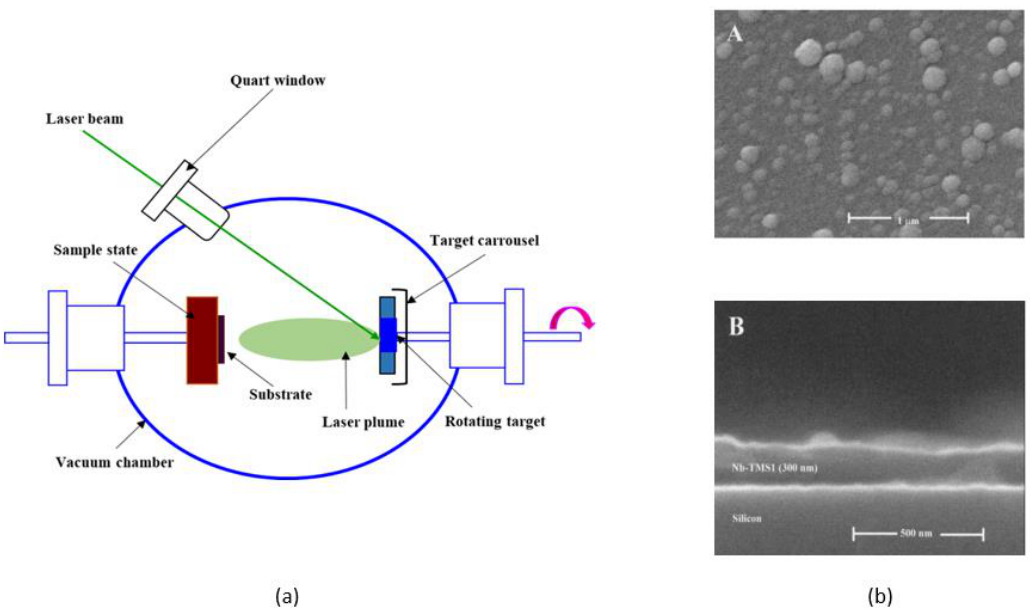
Figure 10. ( a ) Schematic illustration of the pulsed laser deposition process. ( b ) Scanning electron microscope images of the laser deposited Nb-TMS1 film morphology (A) and film cross-section (B). Reprinted with permission from [18]. Copyright 1999 Elsevier.